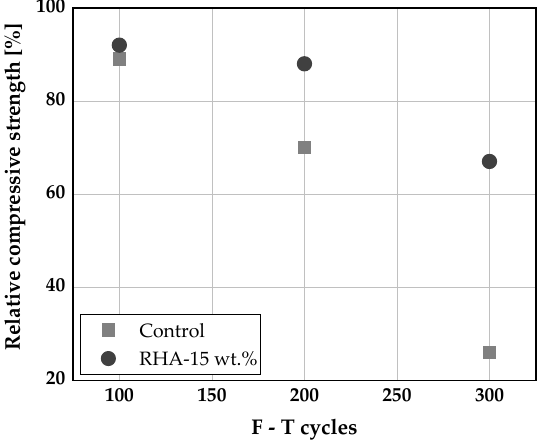
Figure 15. Relative compressive strength of SCC subjected to F-T [153].